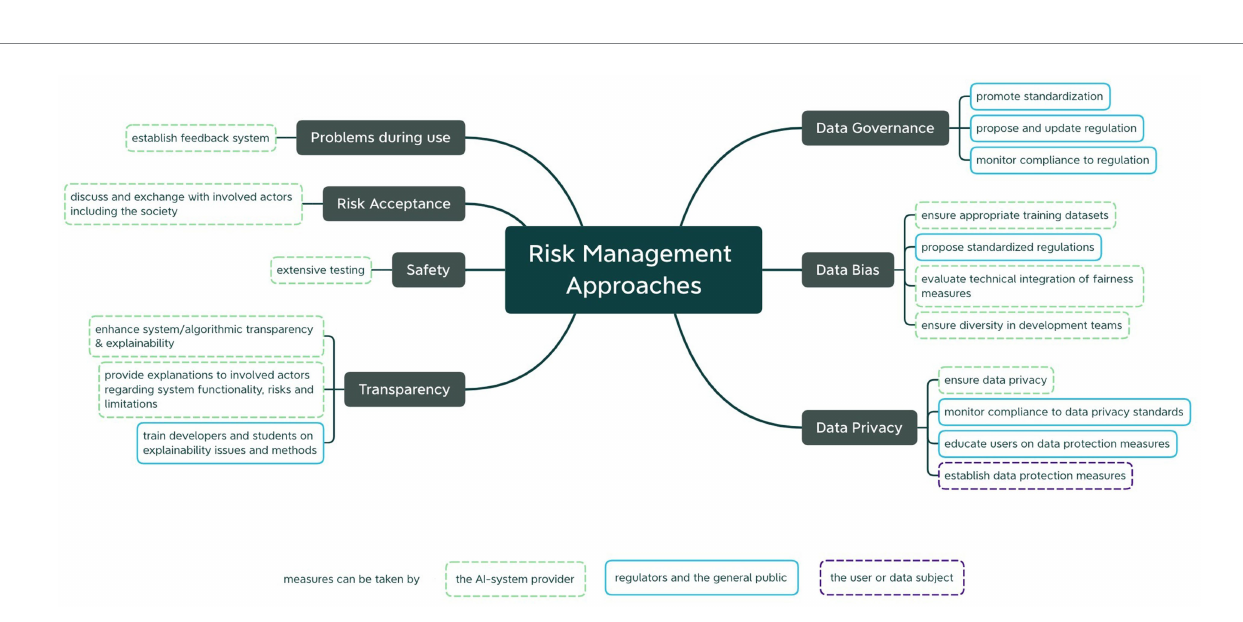
FIGURE 7 Summary of risk management approaches discussed during the use case analysis exercise for selected identified